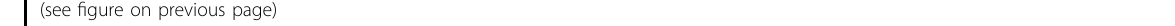
Fig. 5 C/EBP β mediates the upregulation of LCN2 by SIRT2 under ethanol stress. a Venn diagram shows common transcription factors predicted as the putative shared regulators on LCN2, Hp, Saa3, Saa1, Hpx, and Orm2. b Western blot analysis of hepatic LCN2, C/EBP β , and SIRT2 expression in pair and EtOH-fed mice. c , d LCN2 mRNA expression after C/EBP β knockdown (KD) or overexpression (C/EBP β ) in AML12 cells by qRT- PCR analysis. # P < 0.05 and ### P < 0.001 are used to indicate statistical signi fi cance compared between the group with EtOH treatment and the corresponding group without EtOH treatment. e Dual-luciferase reporter assay was performed in HK293T cells. Western blot analysis of C/EBP β expression (top) and luciferase activities of the LCN2 promoter-reporter system (bottom) are shown. f UCSC Epigenome Browser tracks of the C/EBP β ChIP-seq signal − 3 kb before TSS of LCN2 from Cistrome DB ToolKit (top); information about predicted C/EBP β binding sites and the primers targeting different sites on LCN2 promoter (middle); ChIP analysis showing C/EBP β occupancy at the LCN2 proximal promoter in AML12 cells treated with EtOH and control (bottom). PPAR γ and distant region primers were, respectively, used as a positive and negative control. g qRT-PCR analysis of LCN2 mRNA expression in SIRT2 knockdown AML12 cells transfected with C/EBP β . Student ’ s t -test was used for s t atistical evaluation. Data are shown as means ± SD and are considered statistically signi fi cant at * P < 0.05, ** P < 0.01, and *** P <